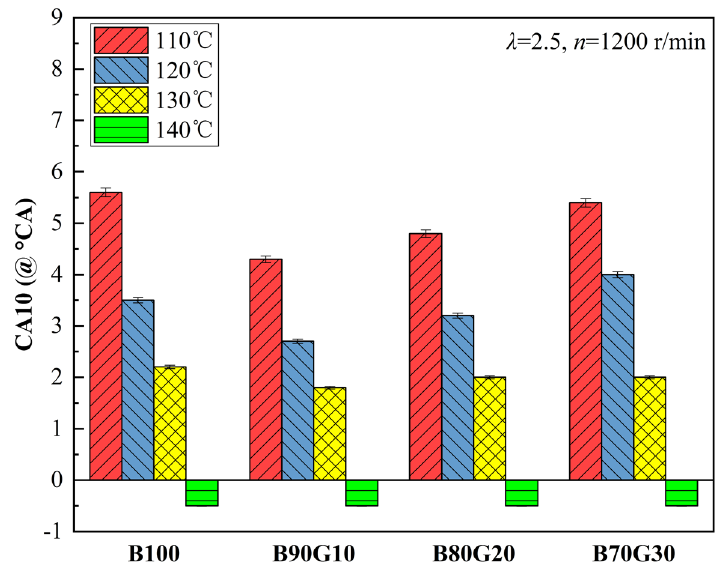
Figure 13. CA10 with different T in s.